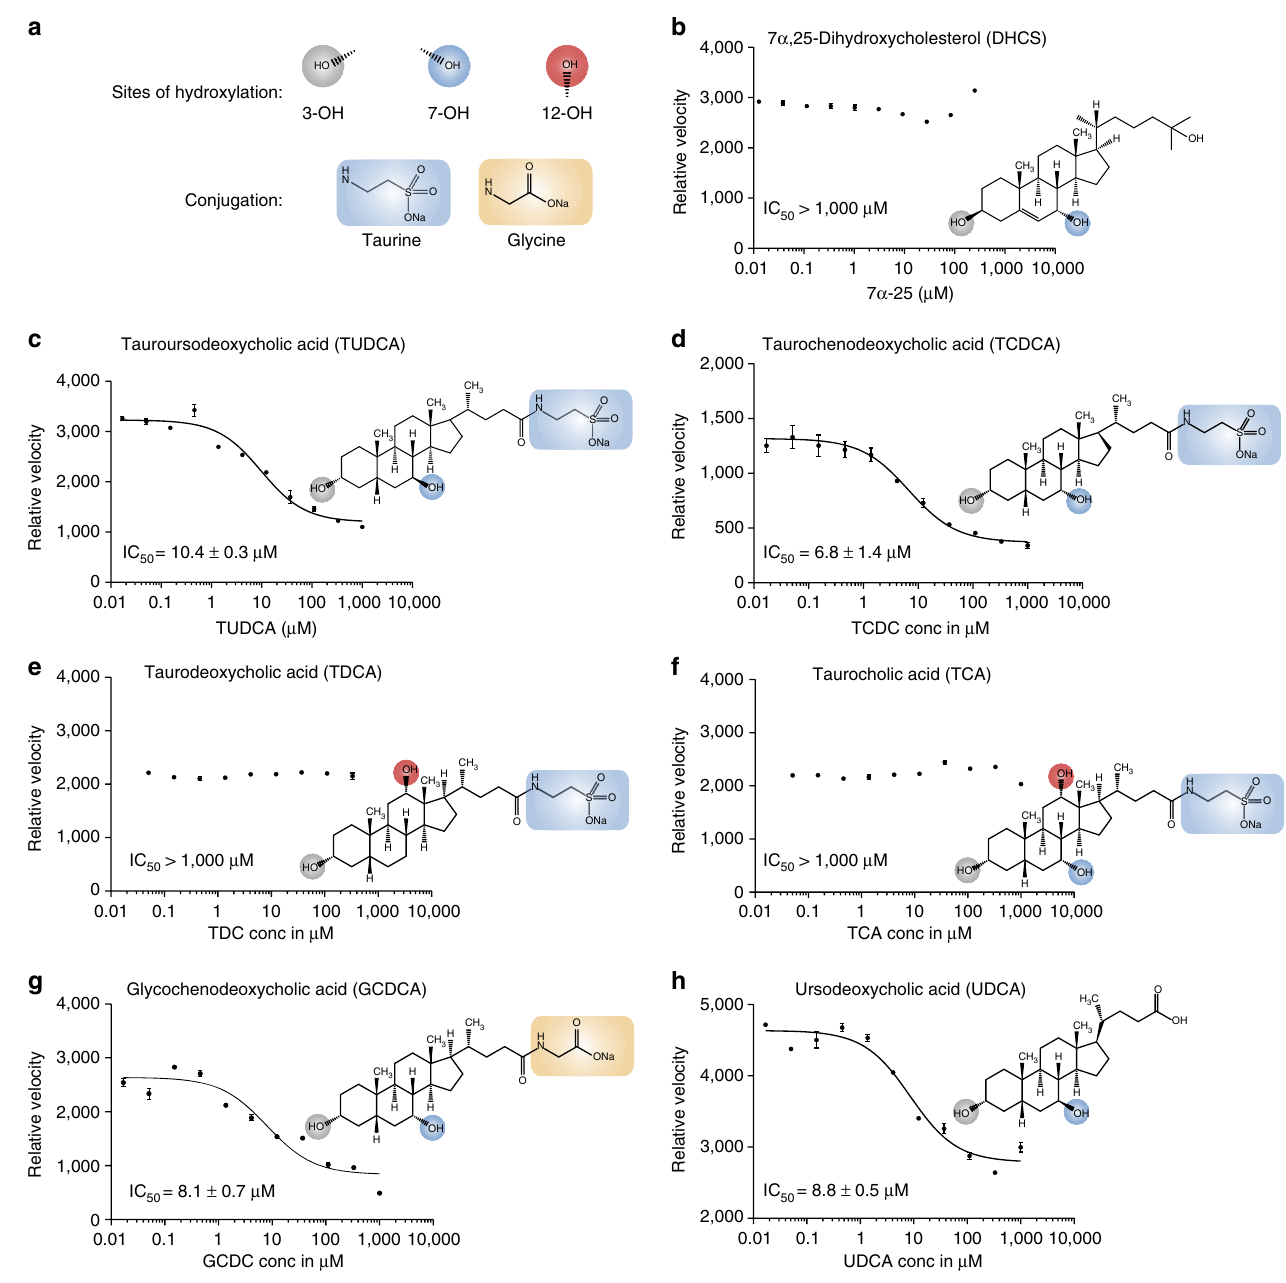
Figure 3 | Activity of ATX in the presence of selected steroids. ( a ) A visual guide to the annotations used for indicating specific functional groups in the bile acids chemical formulas ( b – h ) Inhibition of lysoPLD ATX activity measured as released choline by LPC(18:1) hydrolysis in the presence of specific bile salts with different steroid moiety hydroxylation patterns and acidic tail conjugations. The 12-OH substitution is not tolerated while the conjugation does not affect activity. The grey, blue and red circles highlight the hydroxylation of the steroid backbone; the orange and blue boxes highlight the conjugation partner. The error bars represent s.e.m. from triplicate experiments. Conc,